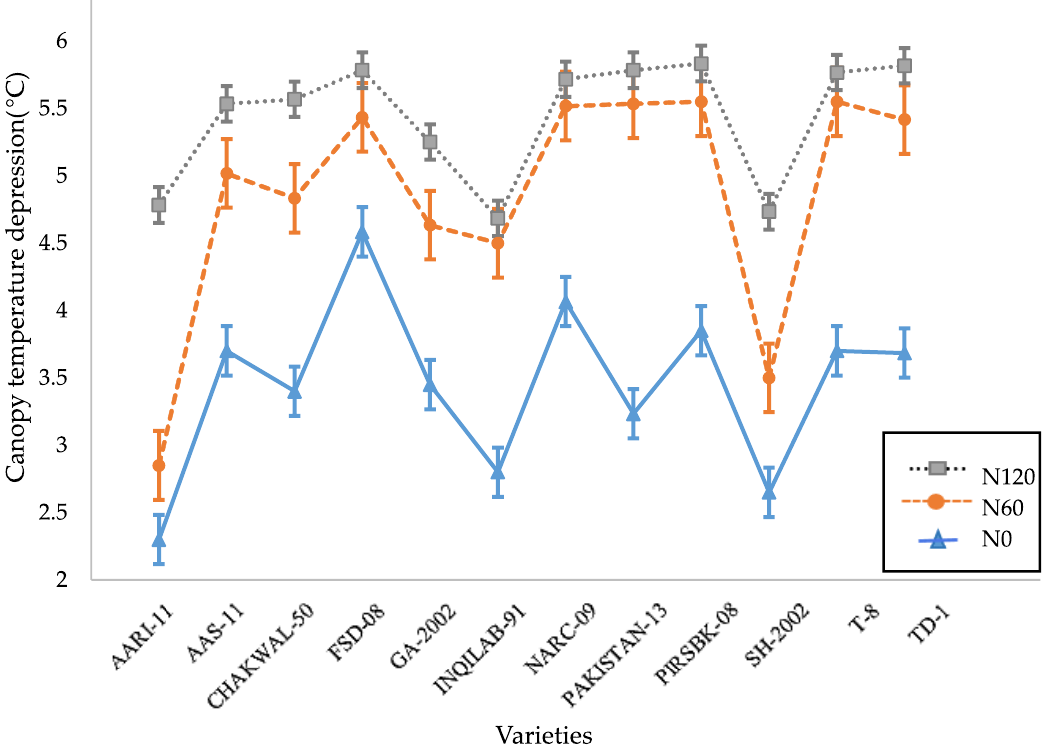
Figure 3. Comparison of mean canopy temperature depression (°C) of twelve wheat varieties cultivated under three different N levels for two years at the National Agricultural Research Centre.